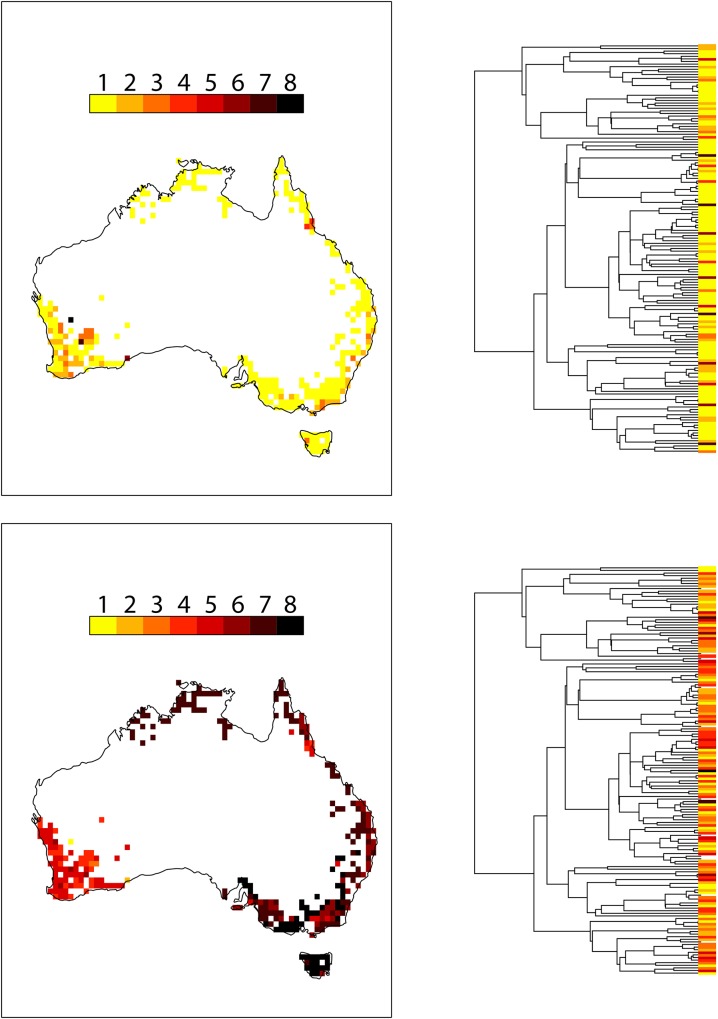
Spatial and phylogenetic patterns in the distribution of threat status and geographic range size.Spatial patterns of threat status (upper panels) and range size (lower panels) are presented as the mean value across species within each 100km2 grid cell, and phylogenetic patterns are presented as species-specific values. Range size is log-transformed and rescaled to the range 0–8 to give units consistent with threat status.